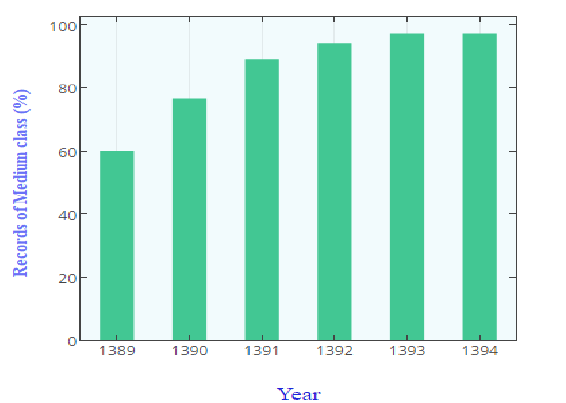
Figure 8. Pasargad Bank